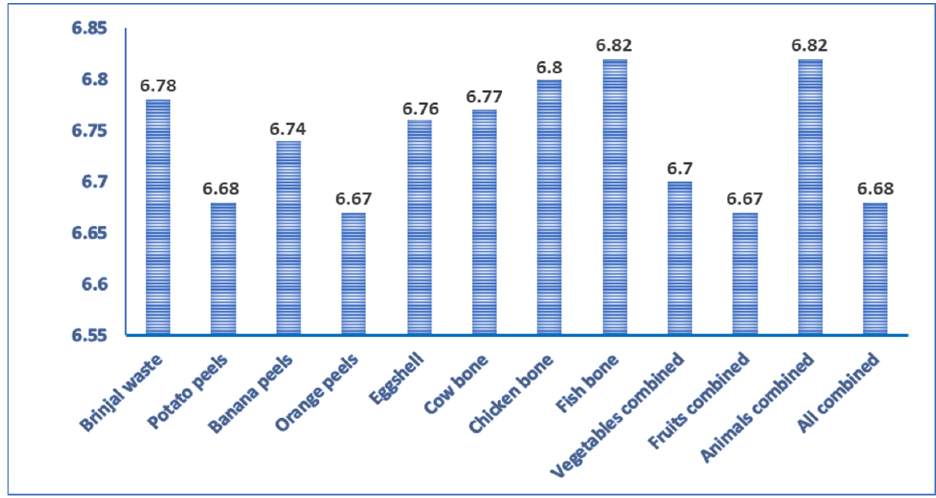
Figure 1. pH of different non-edible food waste.